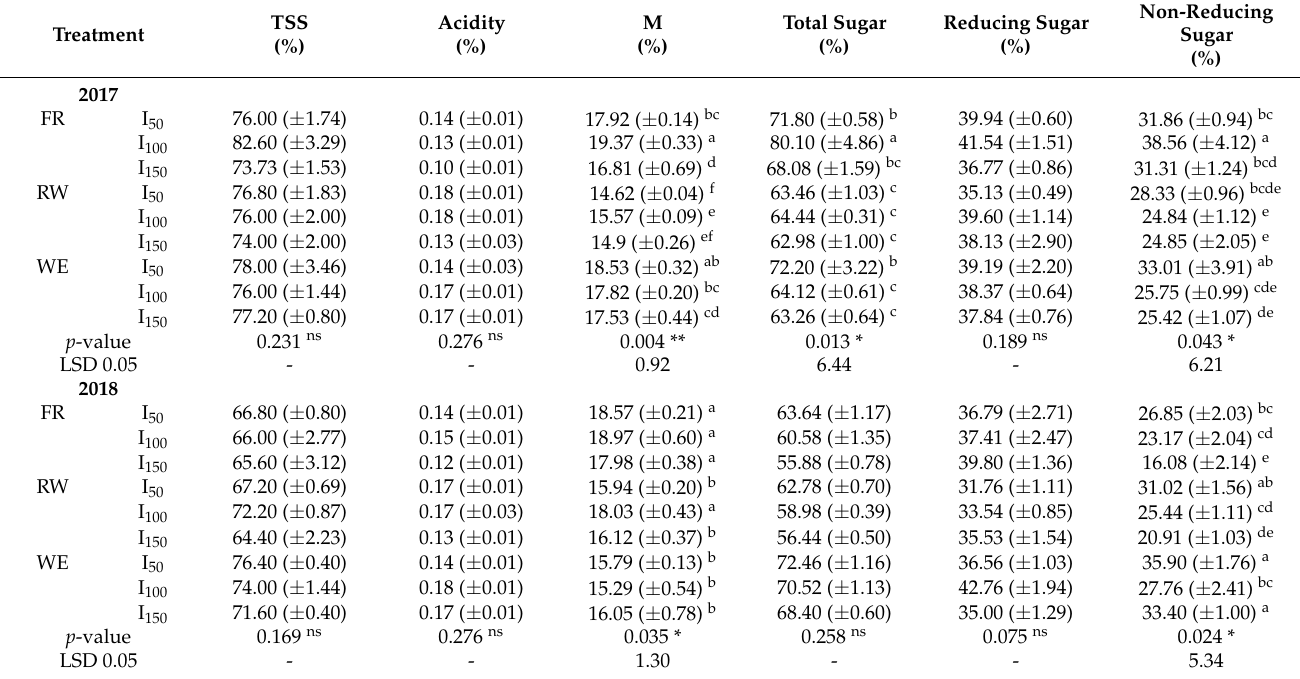
Table 6. Comparison of chemical characteristics of dates across the experimental treatments from 2017 to 2018.